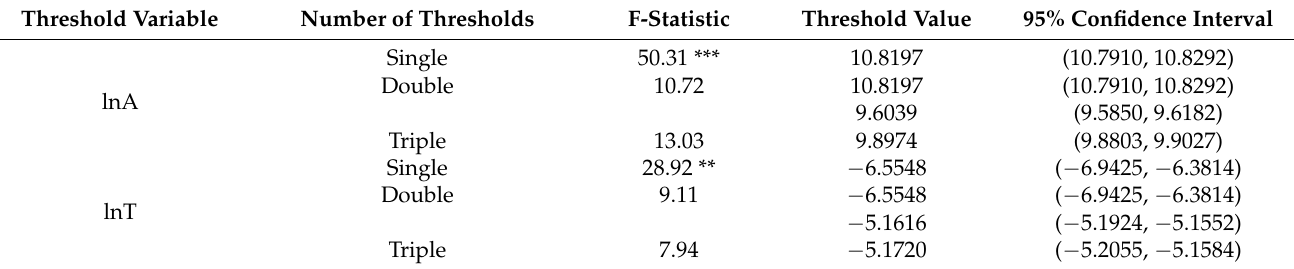
Table 2. Tests for threshold effect and threshold value estimation of the eastern region.